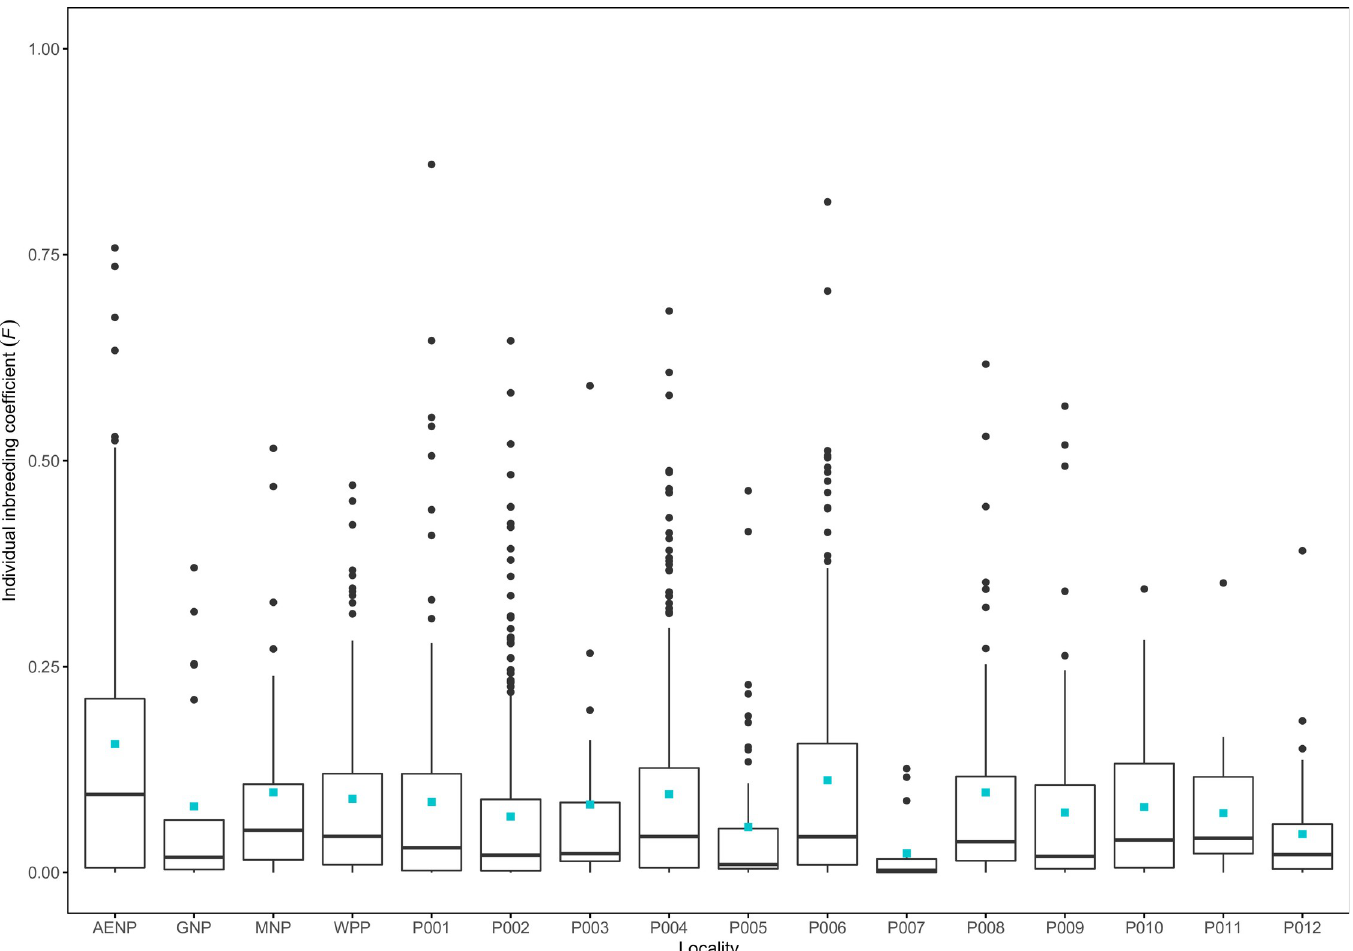
Fig 4. Box and whisker plots showing the distribution of individual inbreeding ( F ) estimates. The lower and upper hinges of the box indicate the 25% and 75% quantiles, respectively, with the horizontal line in the box showing the median. The lower whisker shows the smallest observation greater than or equal to the lower hinge minus 1.5 times the interquartile range and the upper whisker shows the largest observation less than or equal to the upper hinge plus 1.5 times the interquartile range. Points indicate outliers beyond the whiskers. The turquoise squares show the